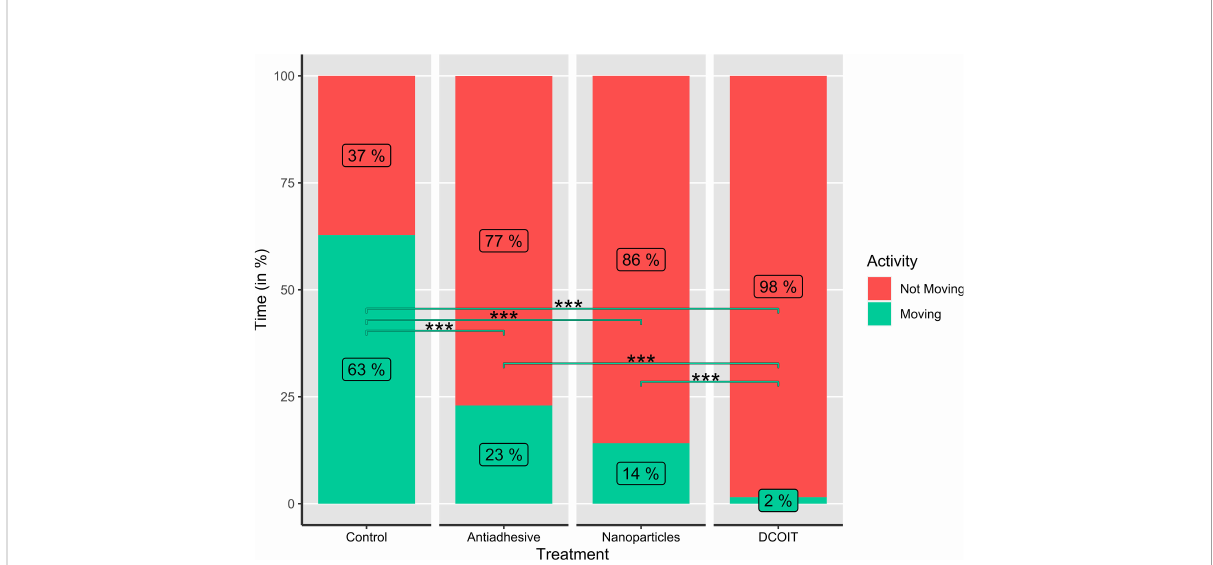
FIGURE 4 Average larval swimming activity (moving/not moving; in %) in each treatment and control (n=32), as indicated by the percentages (rounded) in the bars. Asterisks indicate statistically signi fi cant differences based on pairwise post-hoc tests with estimated marginal means (Supplementary Tables 2, 4; *p< 0.05, **p< 0.01, ***p<